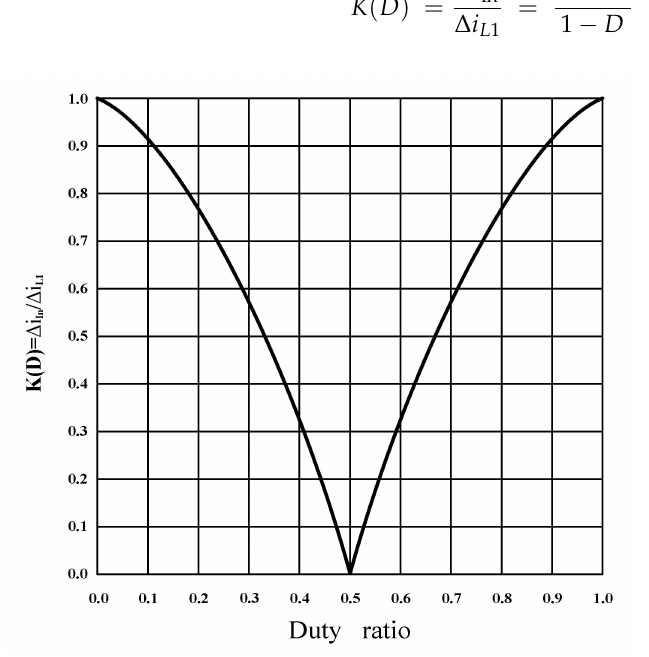
Figure 9. Plot of input inductor ripple current cancellation curve.